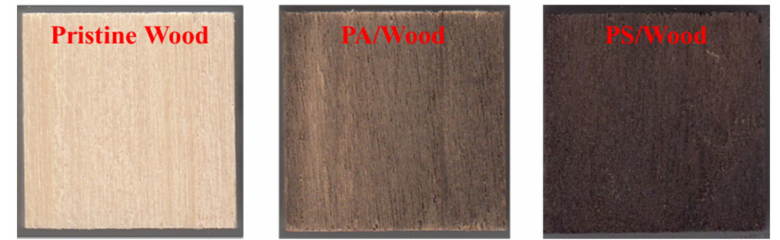
Figure 5. Overall appearances of the wood samples.